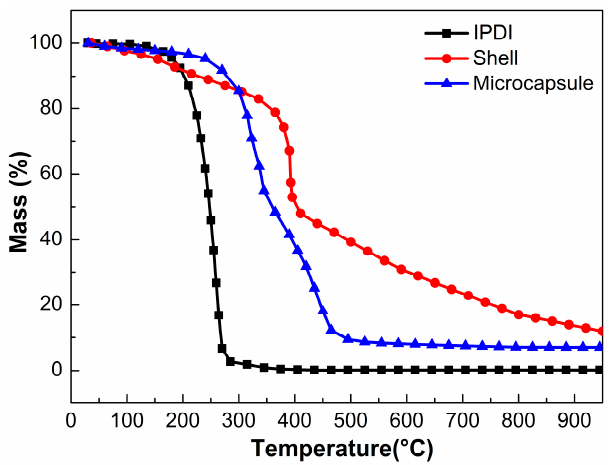
Figure 6. TGA curves of IPDI, microencapsulated IPDI and MF shell.